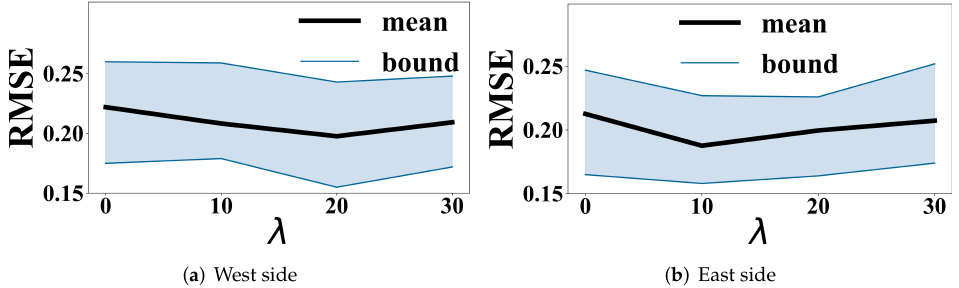
Figure 4. The influence of δ on computation time and prediction performance.